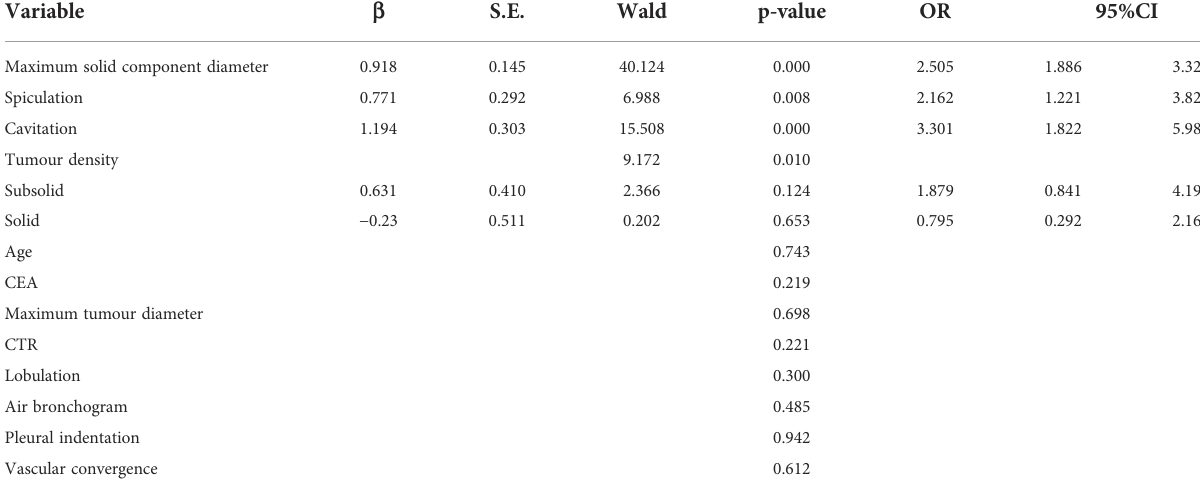
TABLE 4 Multivariable logistic analysis